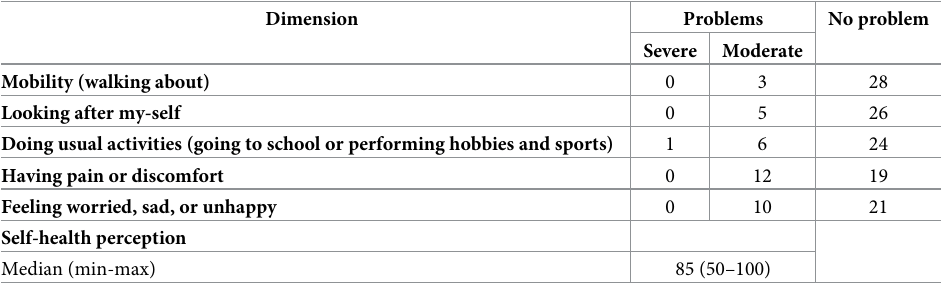
Table 3. Factors associated with the postoperative quality of life of the patients with microtia.